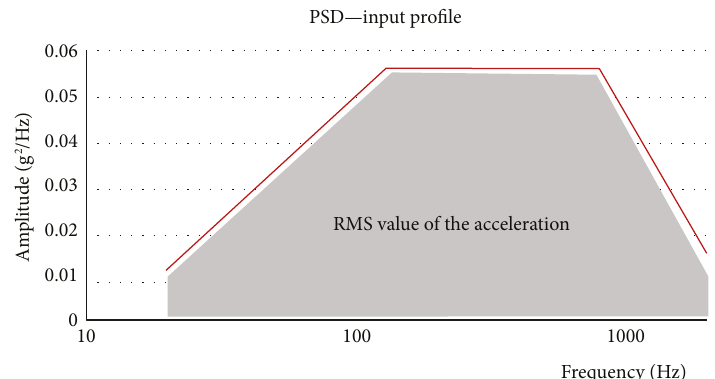
Figure 2: Frequency (Hz) versus amplitude (g 2 /Hz) chart (QB50 mission).